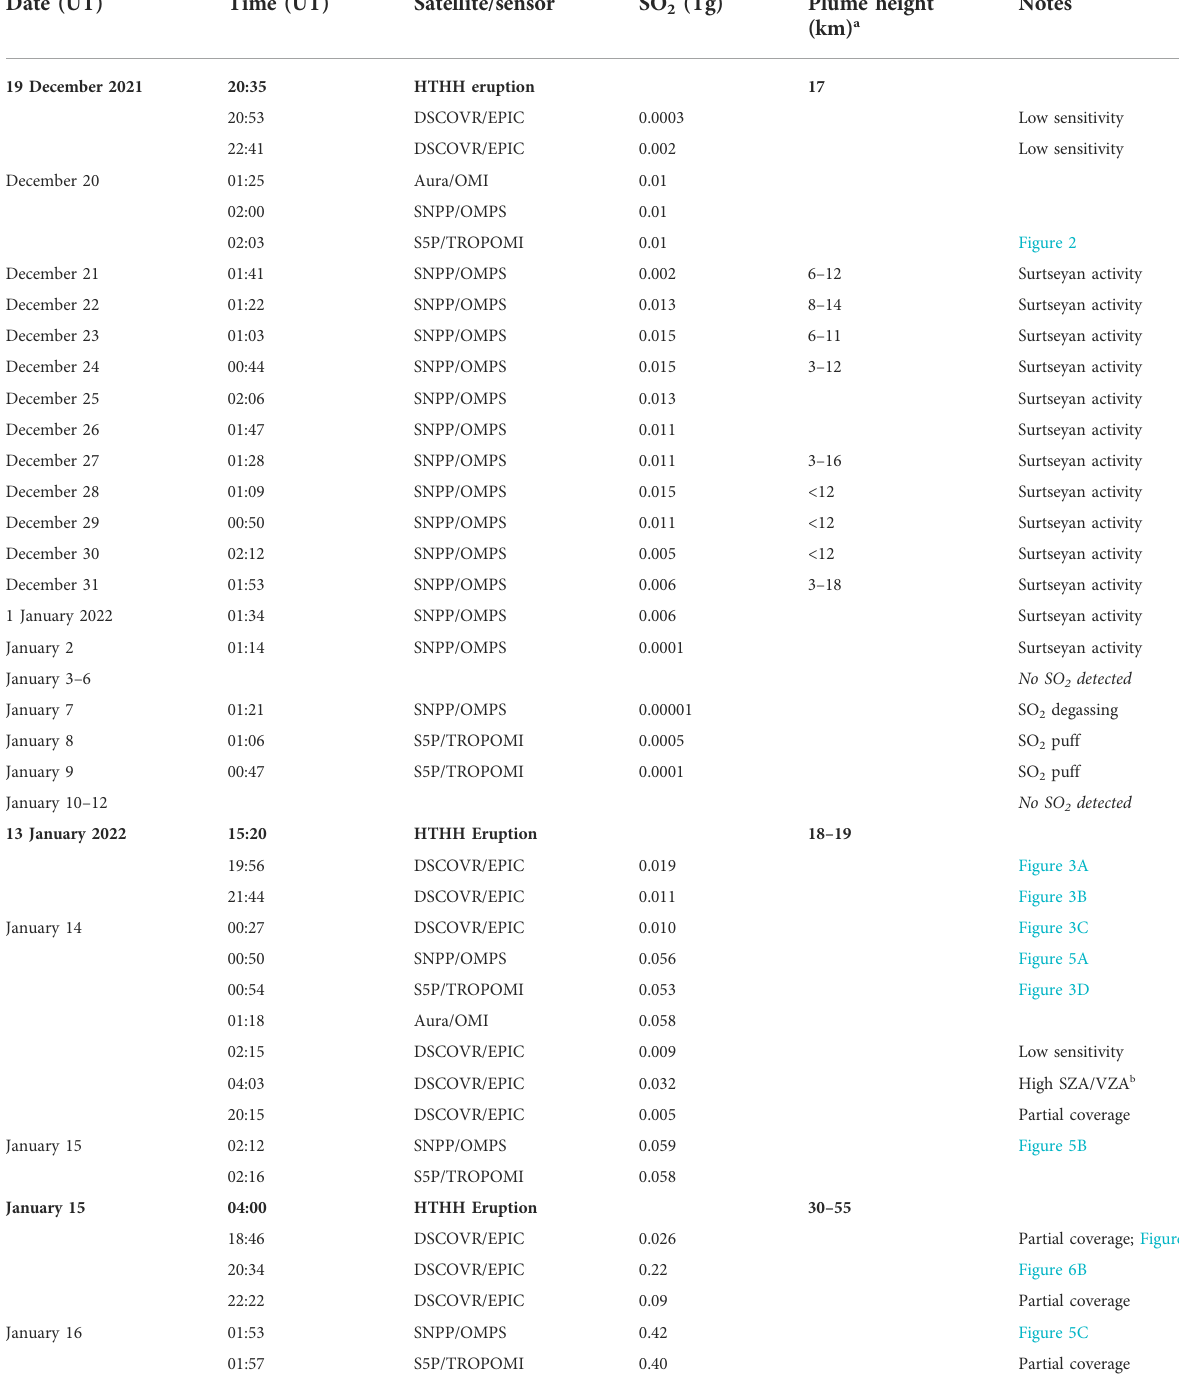
TABLE 2 Satellite measurements of SO 2 emissions from HTHH during the December 2021 — January 2022 eruption